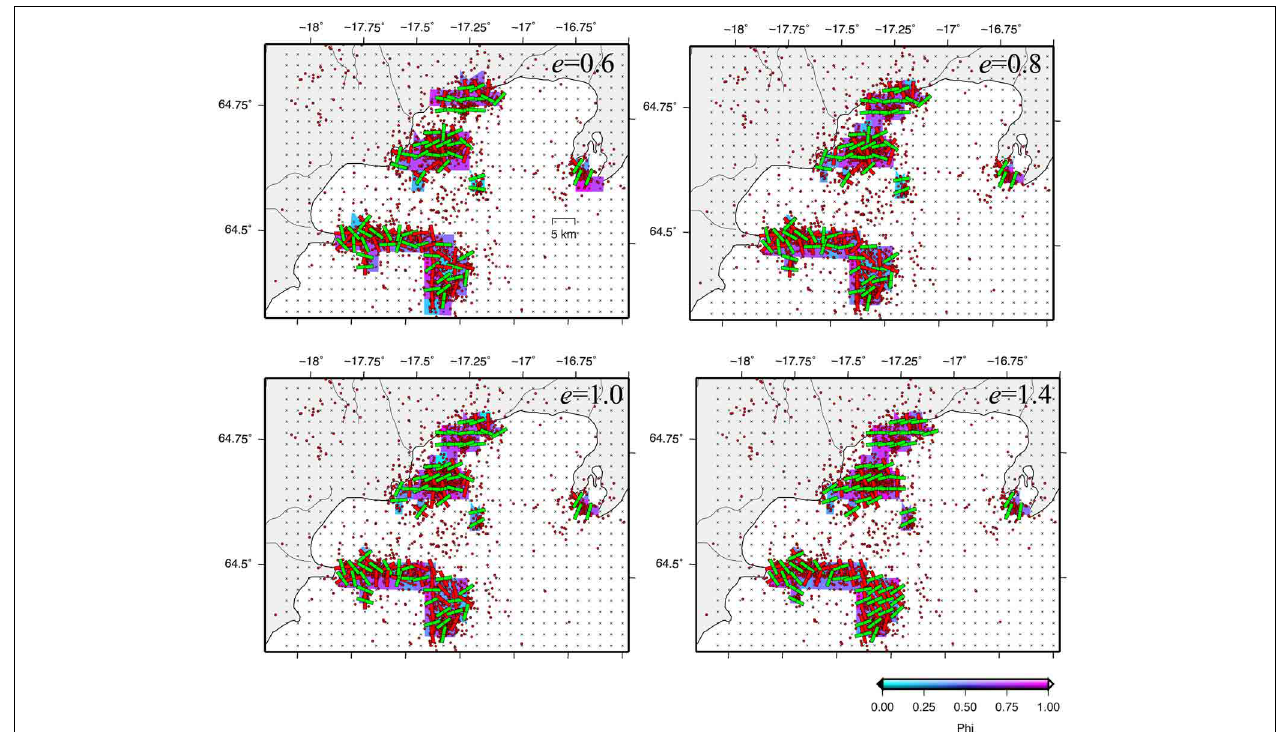
FIGURE 4 | Results for different damped stress fields. The damping parameter e is indicated in each map. Same legend as Figure 3 .